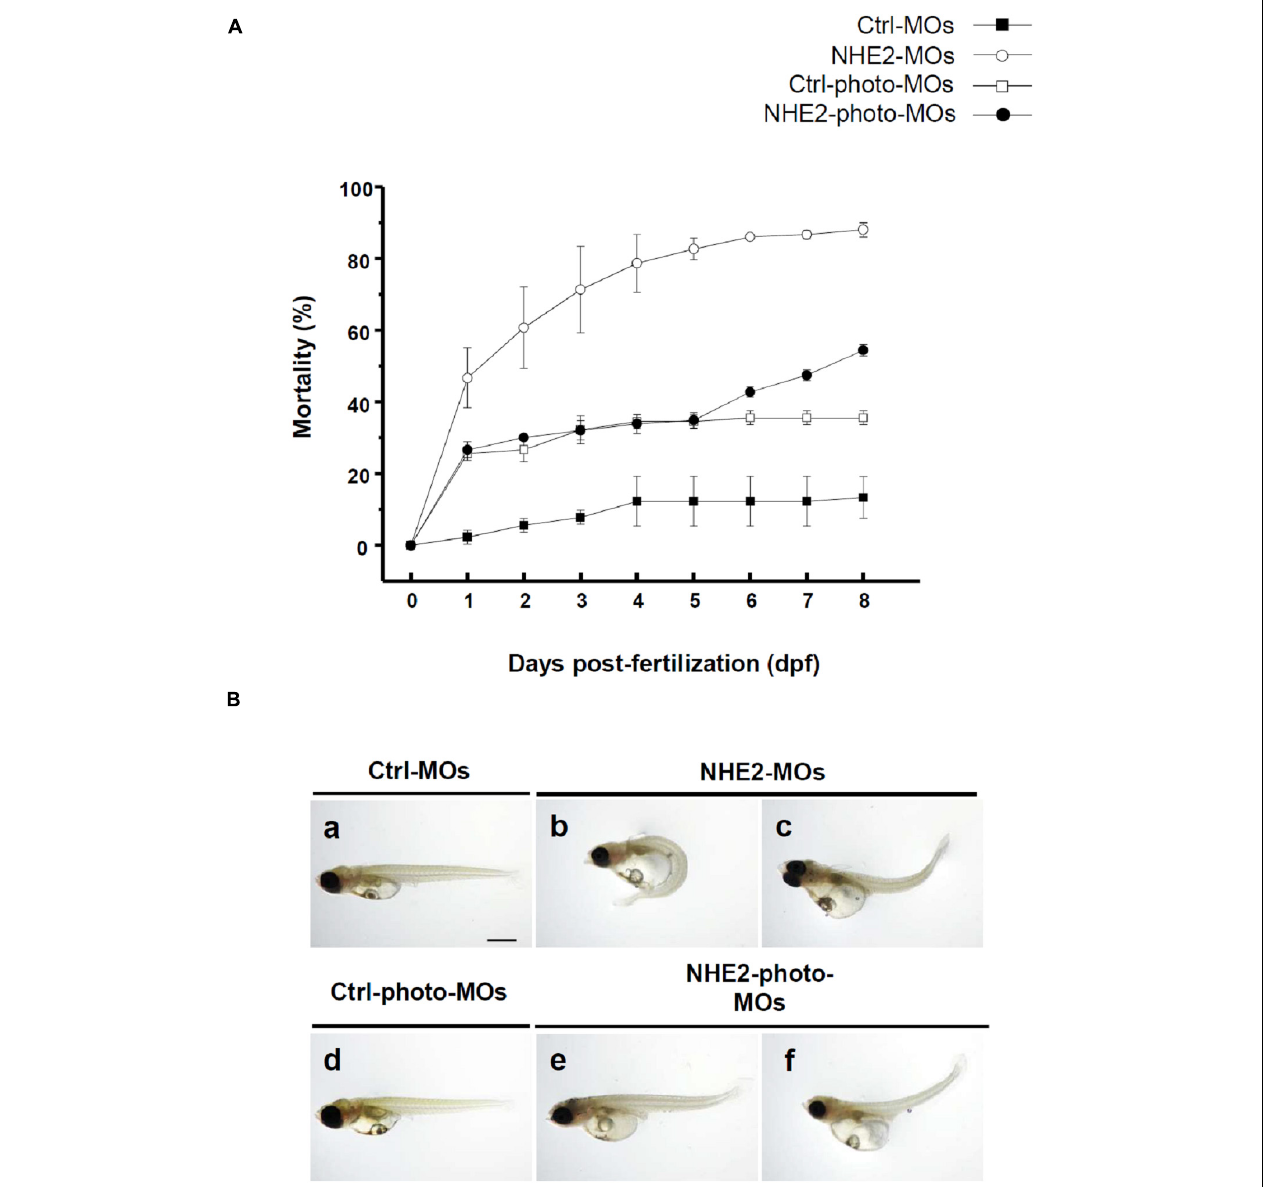
FIGURE 6 | Effects of Na + /H + exchanger 2 (NHE2)-knockdown on mortality and phenotype in seawater (SW)-acclimated embryos. Mortality of control morpholino oligonucleotides (Ctrl-MOs), NHE2-MOs, Ctrl-photoactivated (photo)-MOs, and NHE2-photo-MOs at 0-day post-fertilization (dpf) to 8-dpf SW-acclimated embryos (A) . Phenotypes of Ctrl-MOs, NHE2-MOs, Ctrl-photo-MOs, and NHE2-photo-MOs of 8-dpf SW-acclimated embryos (B) . Scale bar is 200 µ